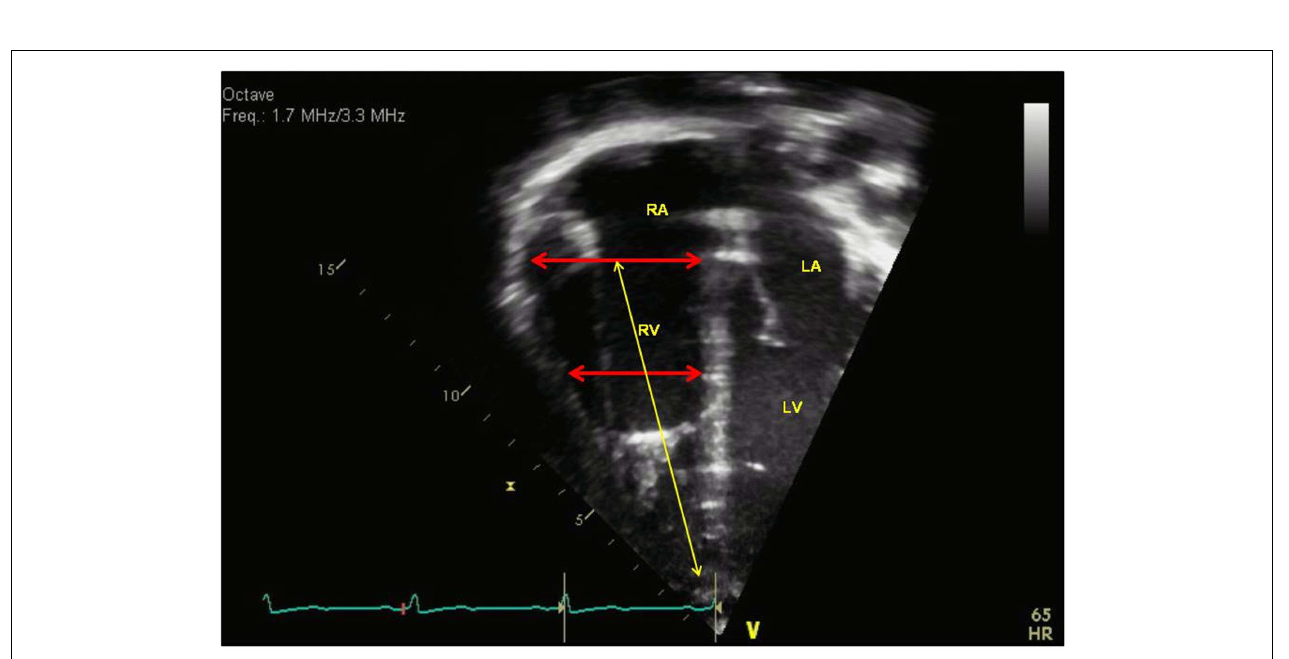
FIGURE 2 | Measurement of right ventricular dimensions in end-diastole with basal dimension at the level of the tricuspid valve, the mid-cavity dimension (red arrows), and longitudinal dimension (yellow arrow) . RA = right atria, RV = right ventricle, LA = left atria, LV = left ventricle.